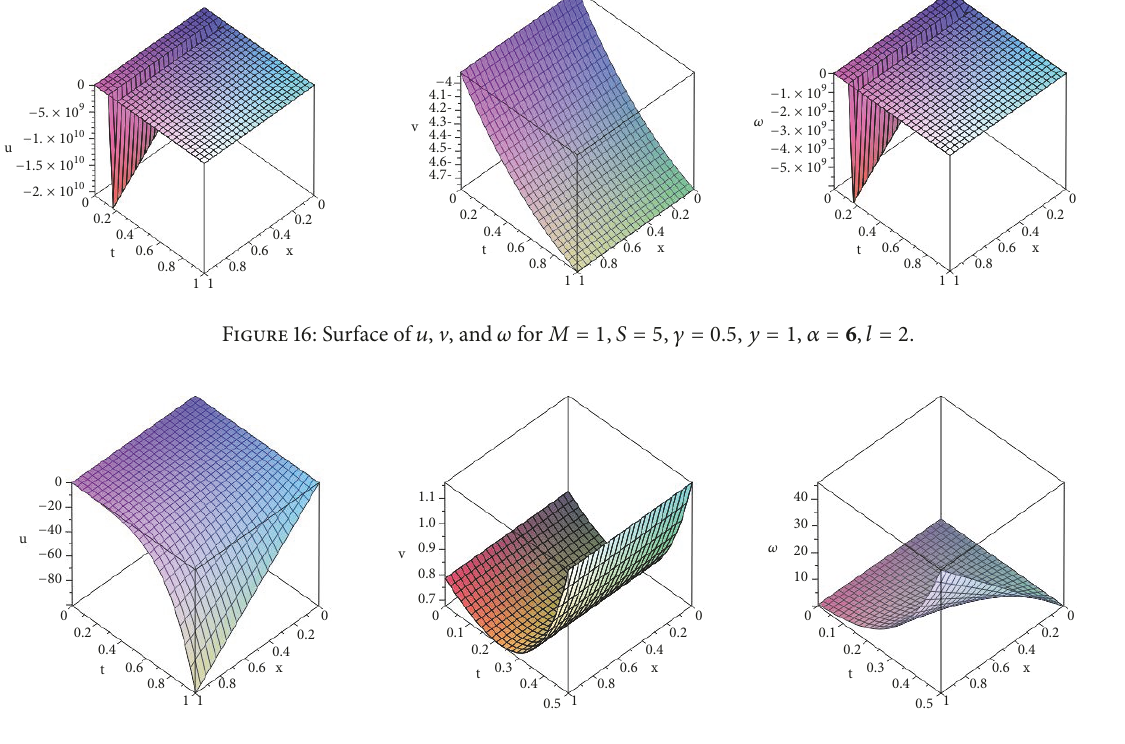
Figure 17: Surface of 𝑢 , V , and 𝜔 for 𝑀 = 2 , 𝑆 = −10 , 𝛾 = 0.3 , 𝑦 = 1 , 𝛼 = −2 , l = 0.8 .